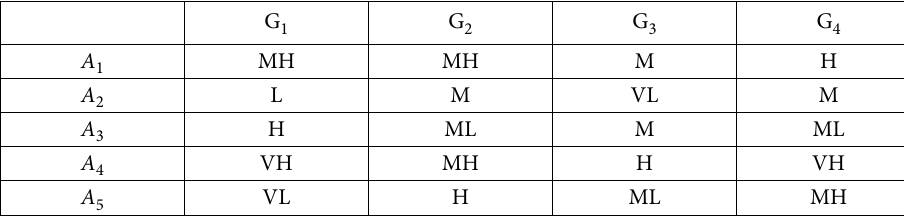
Table 3. Linguistic assessing matrix by second expert